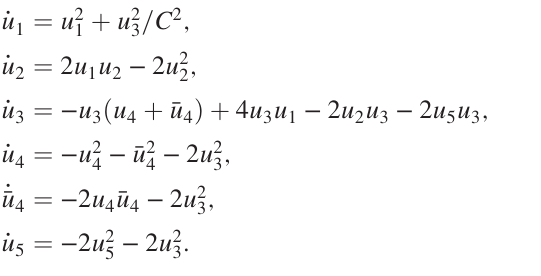
orbital content. The xy =d electron xz yz